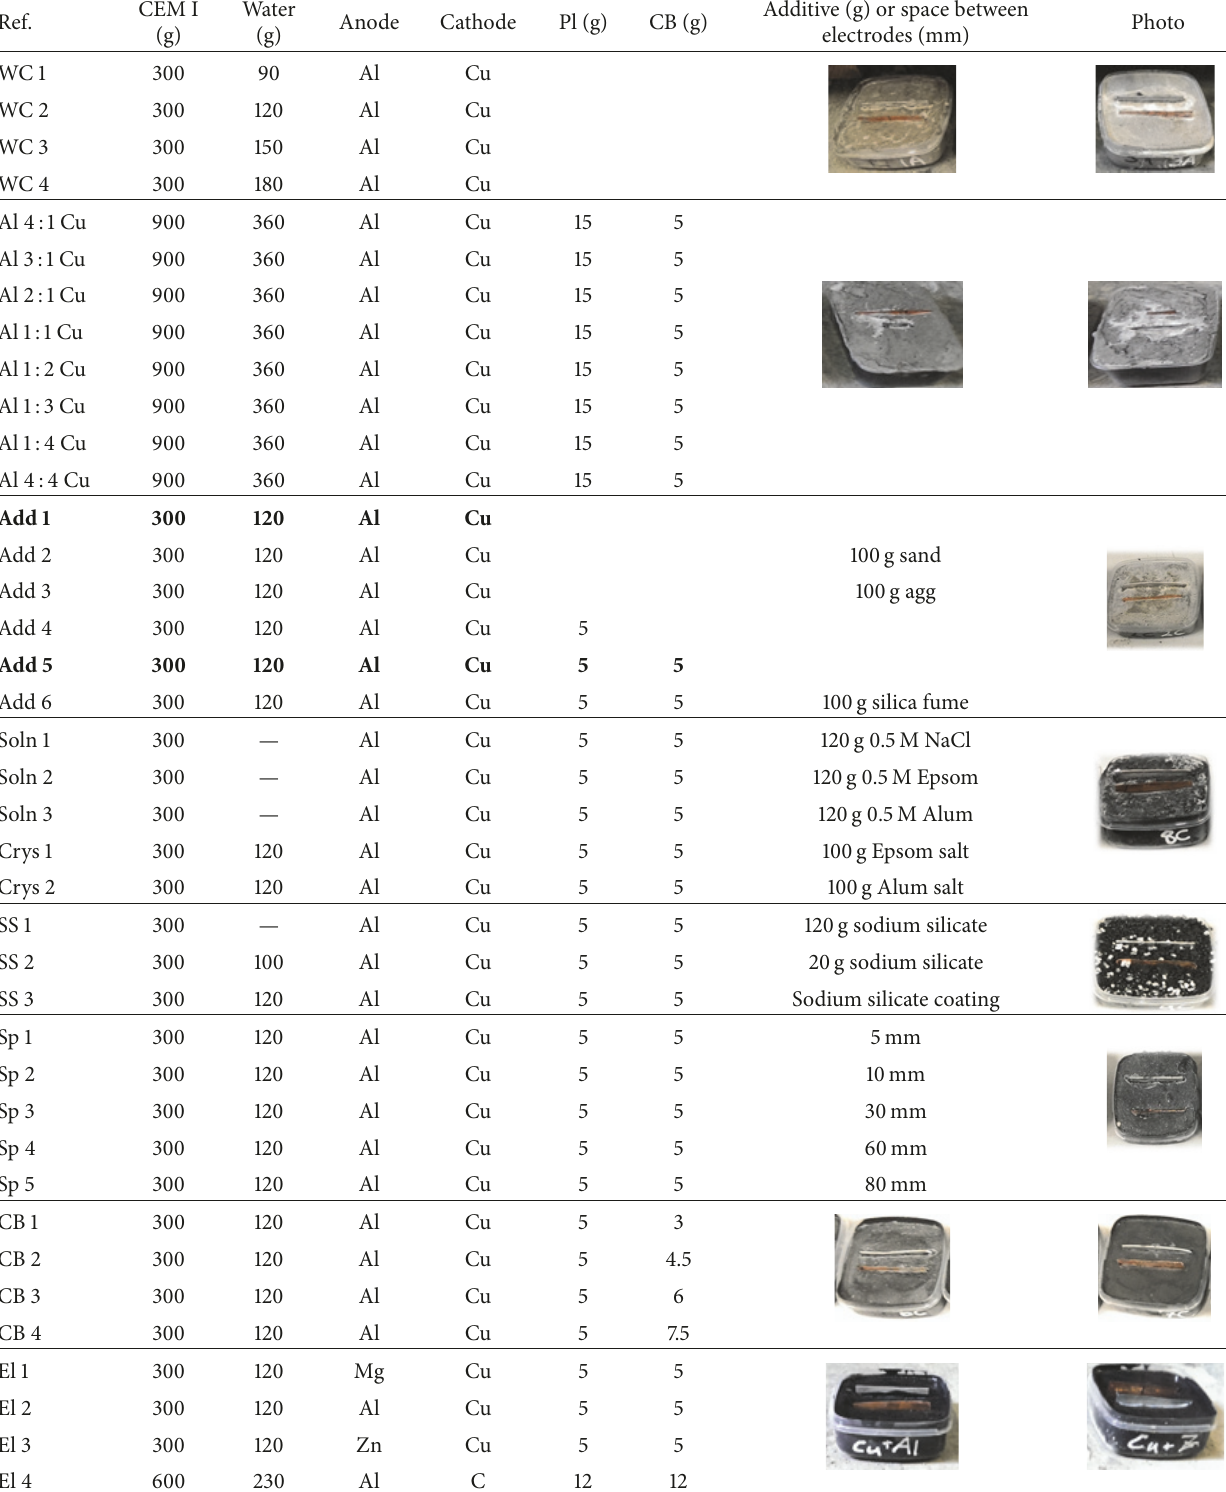
Table 3: Cement battery